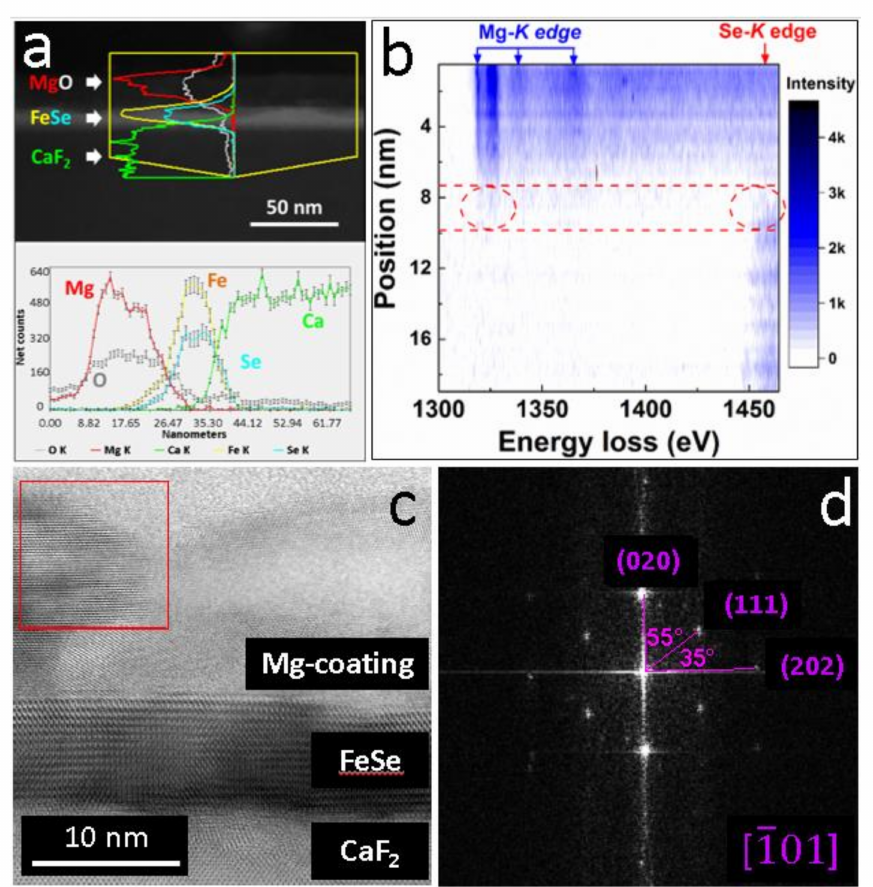
Figure 5. The STEM-related characterizations for #UFM3 from a cross-sectional view. ( a ) EDS linear-scanning showing the distribution of Mg, O, Fe, Se and Ca elements; ( b ) The EELS contour image illustrating the evolution of Mg- K and Se- K edges. The region in which Mg and Se coexist is highlighted between dashed lines; ( c ) A bright-field STEM image captured from the zone axis of (cid:2) (cid:3) 101 ; ( d ) The FFT pattern of the polycrystalline region in the square in ( c